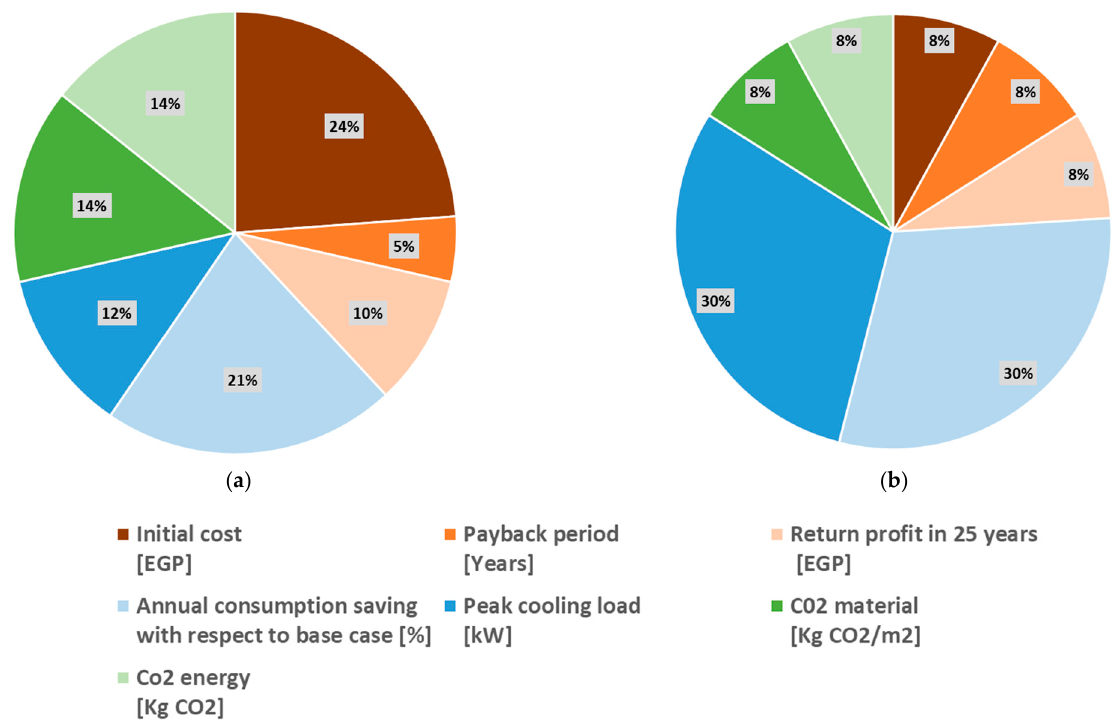
Figure 6. The key performance indicators (KPIs) for each parameter in each scenario; ( a ) overall normalized scenario; ( b ) energetic scenario .